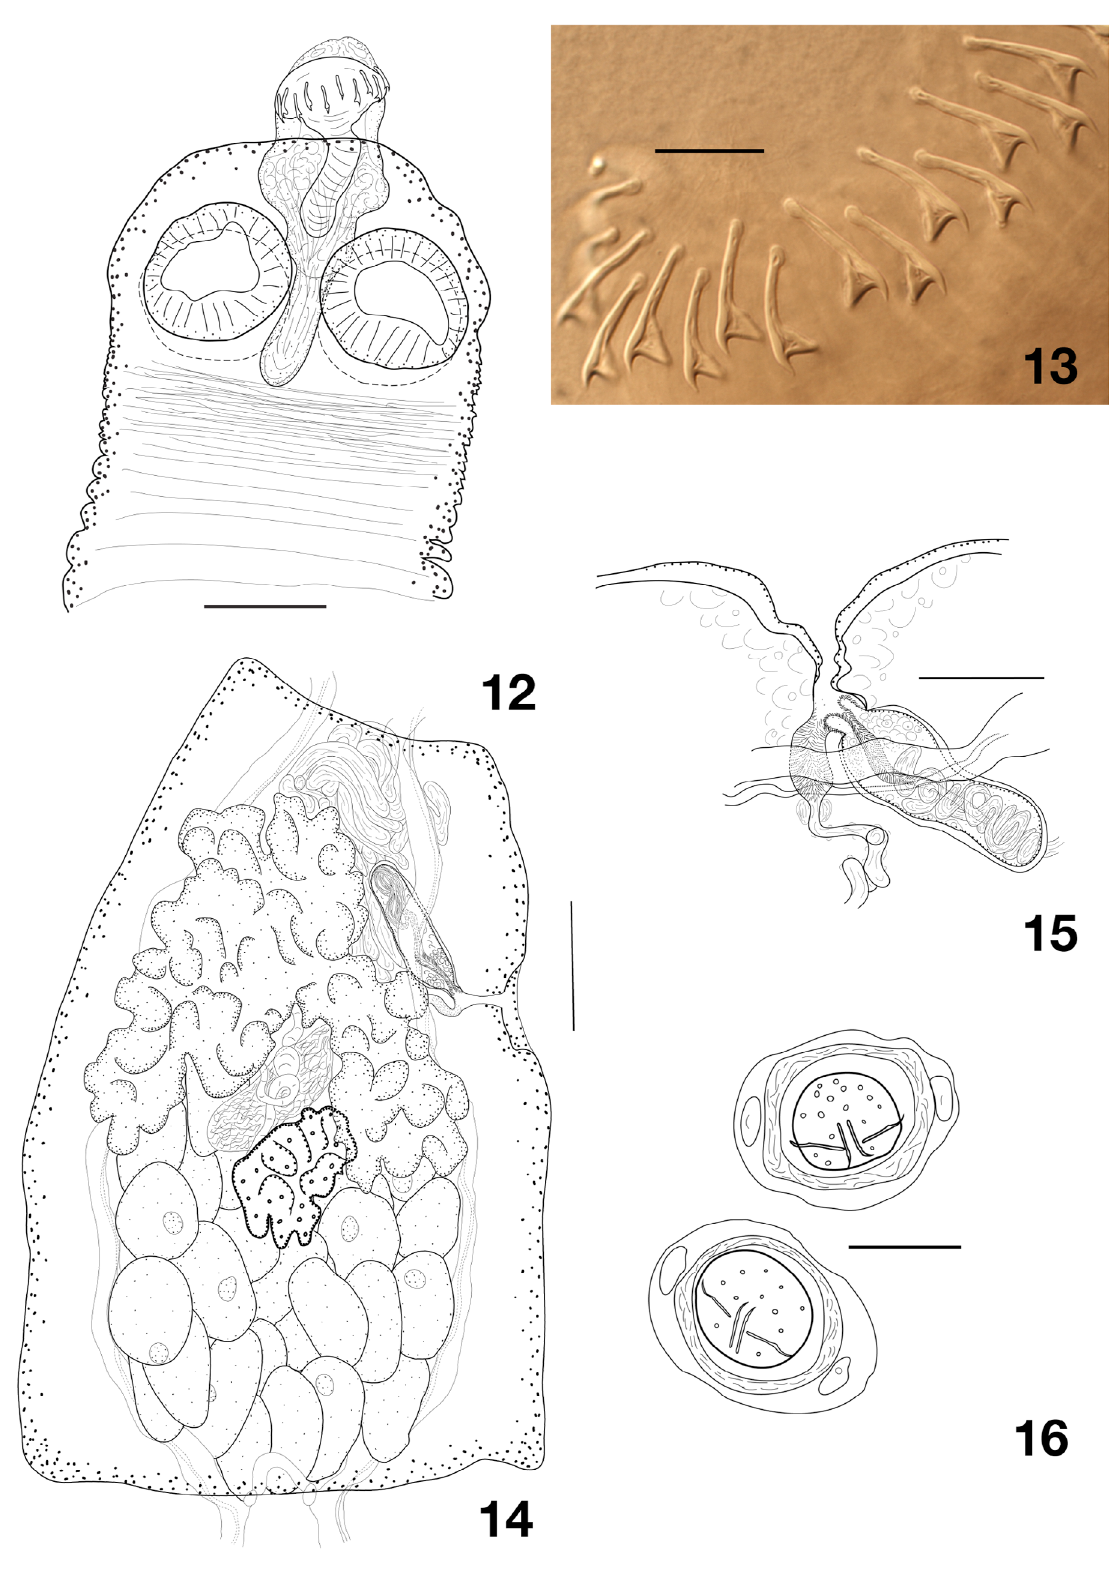
Figs 12–16. Monopylidium australiense sp. nov. 12 . Scolex. 13 . Hooks. 14 . Mature proglottis. 15 . Terminal genitalia. 16 . Eggs. Scale bars: 12, 14 = 100 µm; 13, 16 = 20 µm; 15 = 50